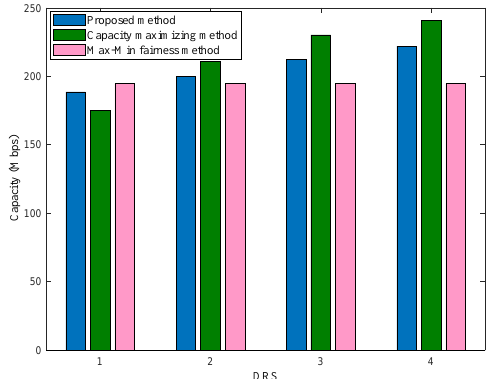
Figure 9. Capacity distribution for 4 DRSs in scenario